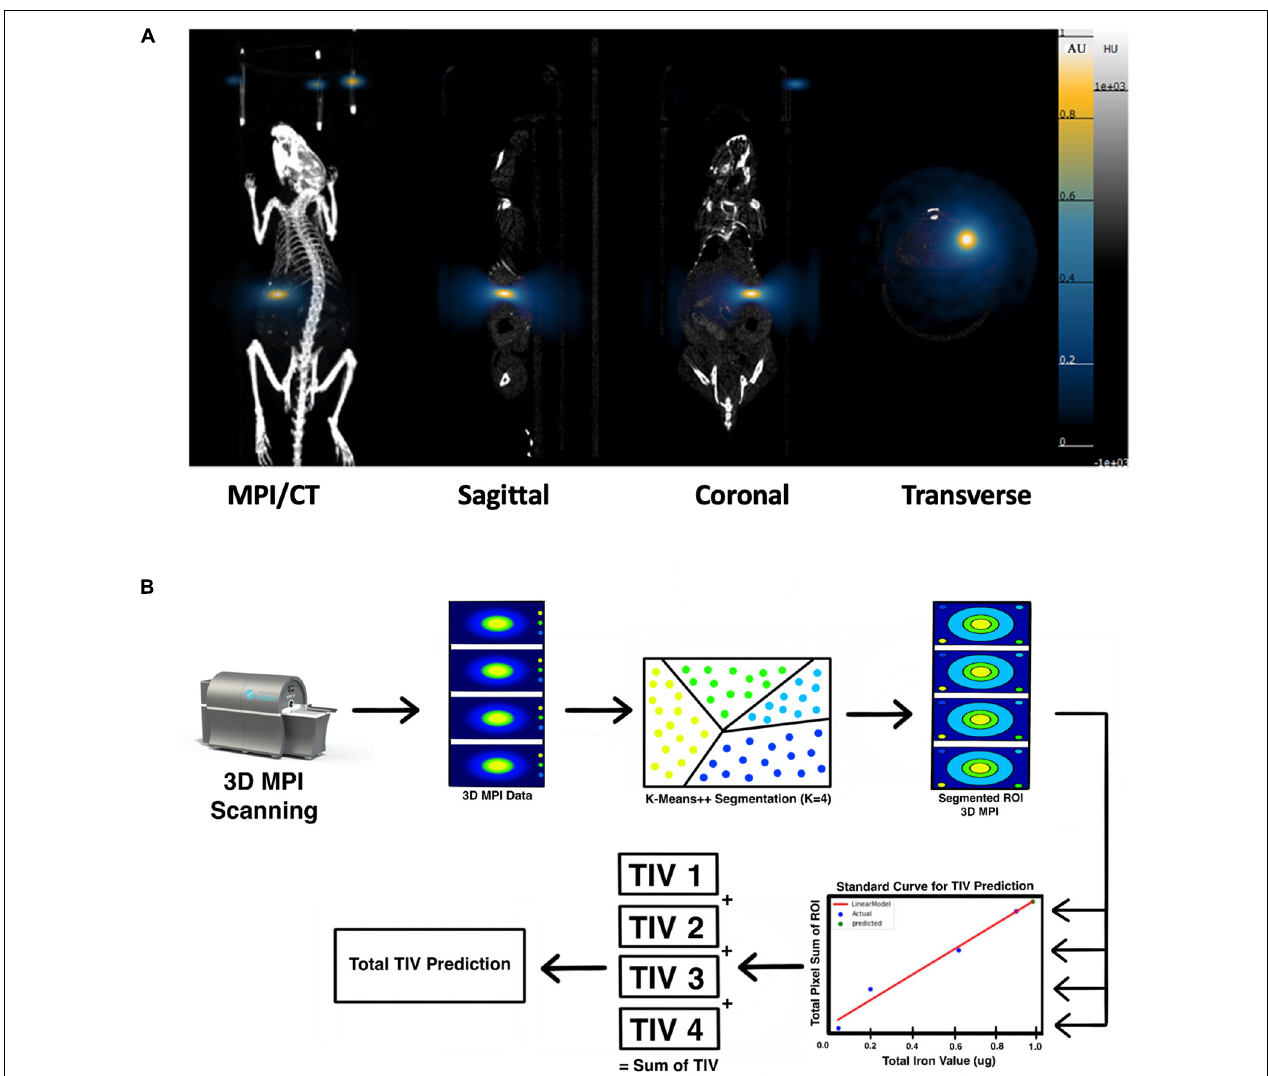
FIGURE 5 | (A) 3D reconstructed MPI co-registered with microCT imaging of ViviTrax labeled islet organoids under the left kidney capsule of mouse on day 1 post-transplantation, all animals were placed in the prone position for both MPI and CT scanning. (B) Overview of the K-means ++ algorithm for segmentation and TIV